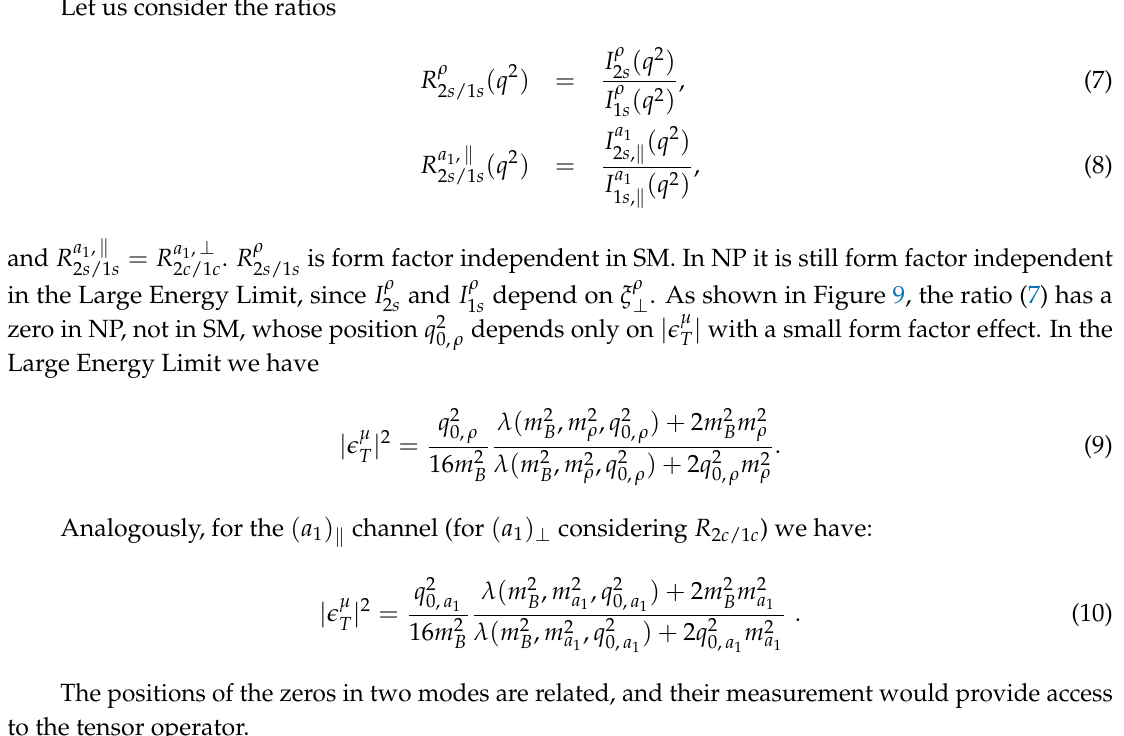
Figure 5. ¯ B → ρ ( ππ ) µ − ¯ ν µ : angular coefficient functions I ρ